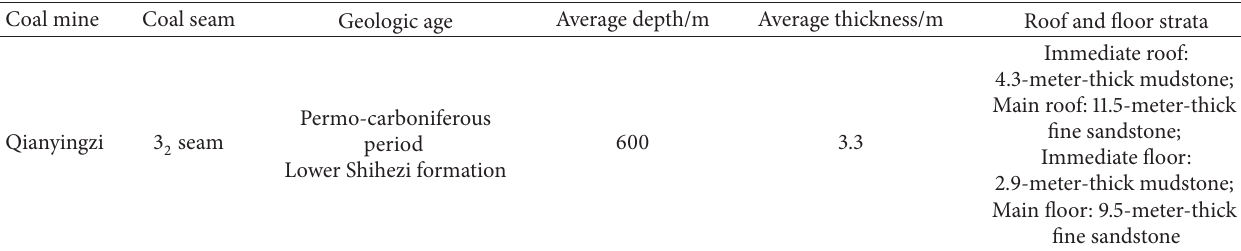
Table 1: Characteristics of the 3 2 coal seam.